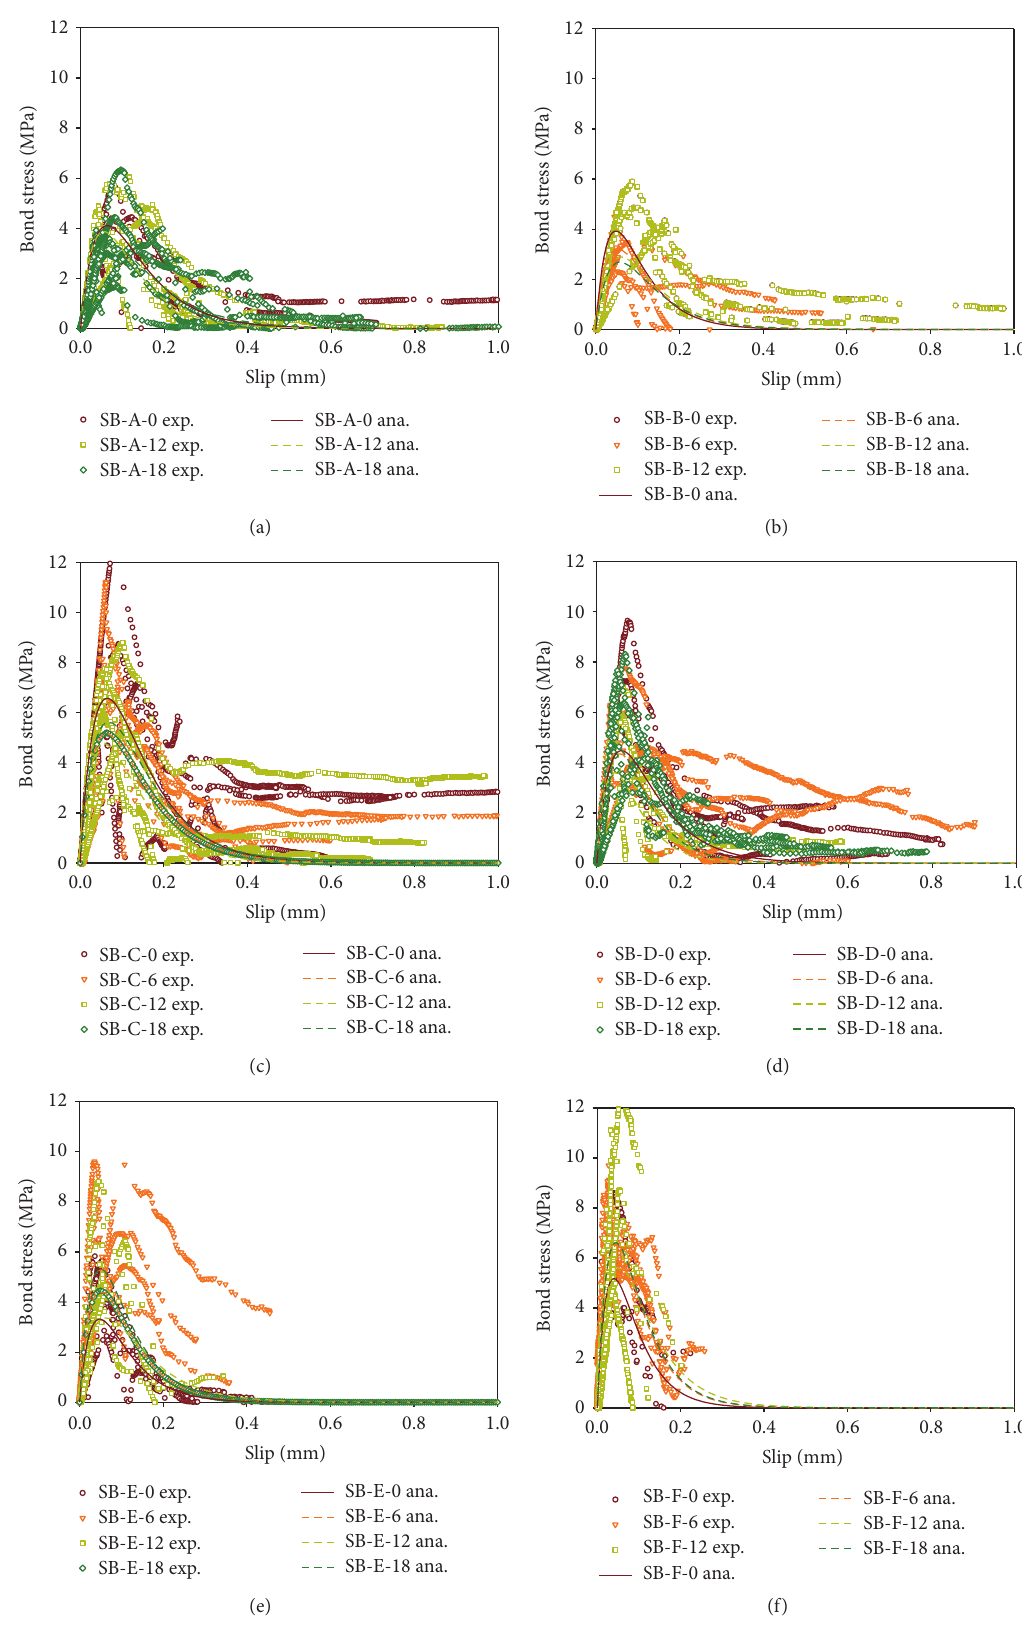
Figure 9: Comparison of predicted bond-slip models with the experimental